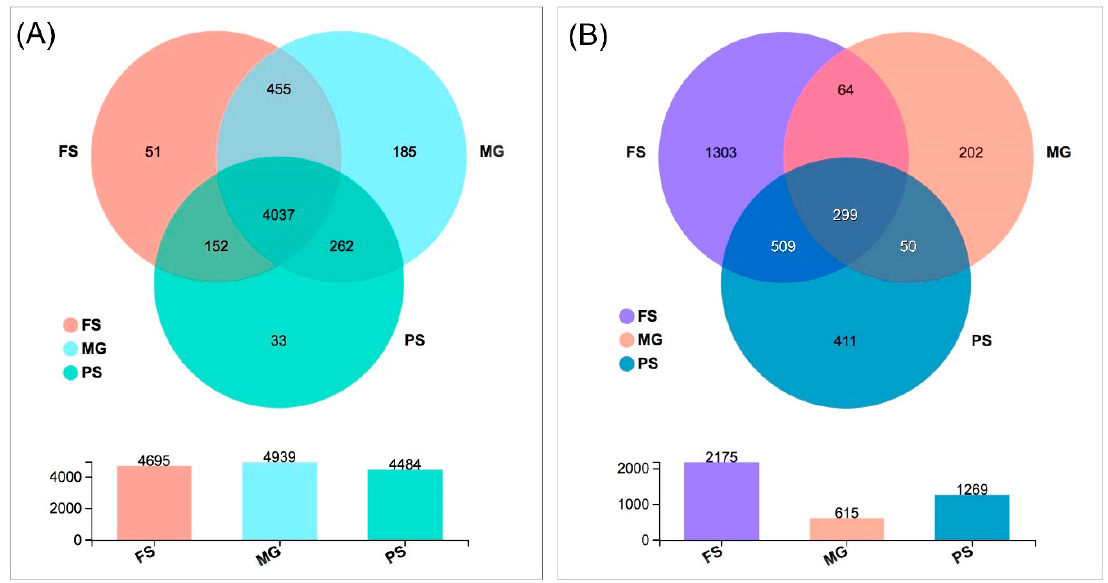
Figure 2. Venn diagram showing the number of shared and unique bacterial ( A ) and eukaryotic ( B ) OTUs among the samples extracted using the FS, MG, and PS kit.